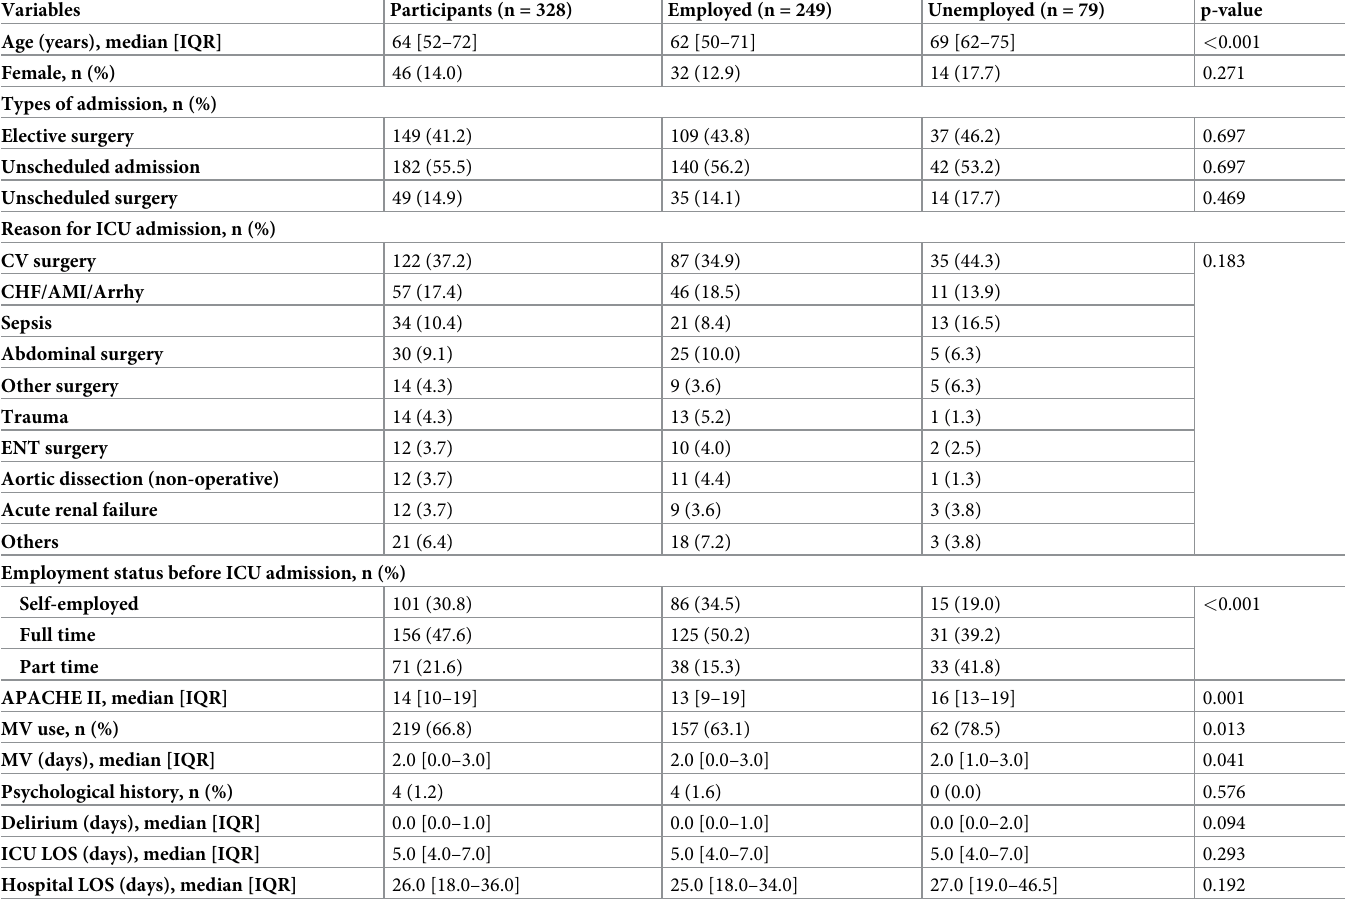
Table 1. Demographic characteristics of employed and unemployed subjects 12 months after intensive